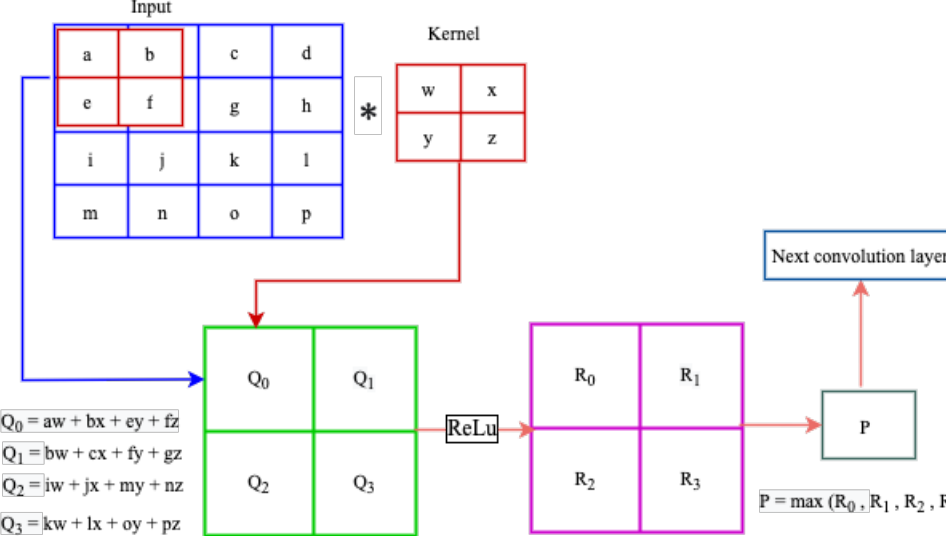
Figure 3. Components of a typical CNN layer.